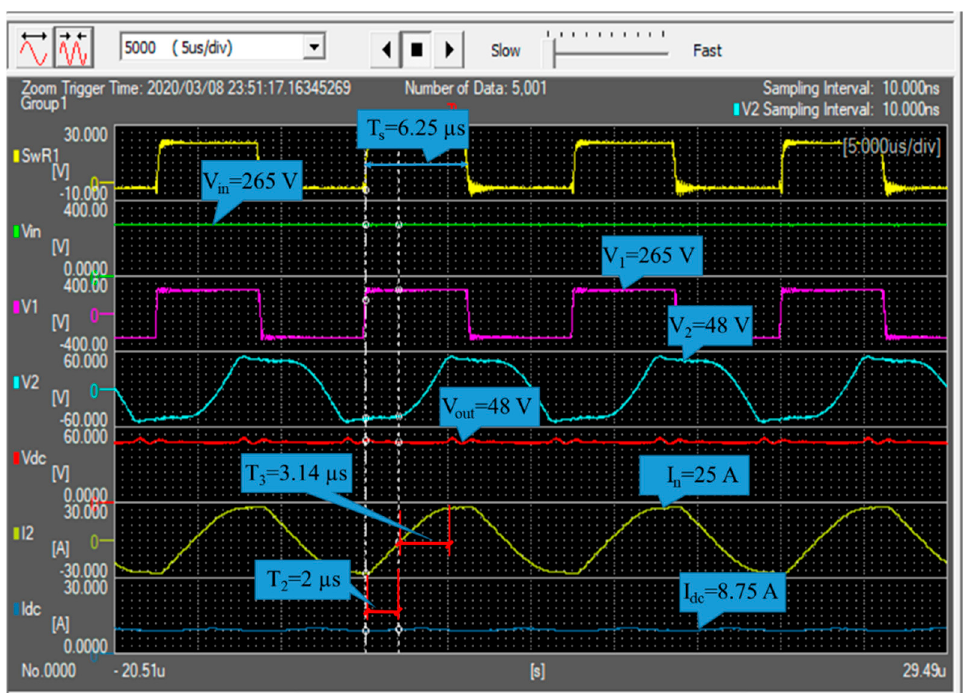
Figure 10. Experimental voltage and current waveforms at (cid:1858) (cid:3046) = 80 kHz .